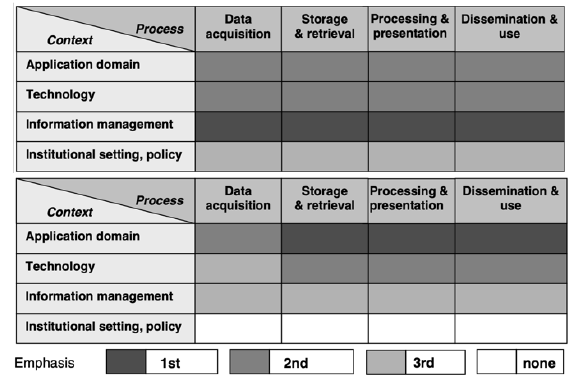
Figure 4. The bottom-up BoK model best suited for mid- career professionals for Geospatial information management (top) and for Urban Planning and Land Administration CD program (after Molenaar, 2002).